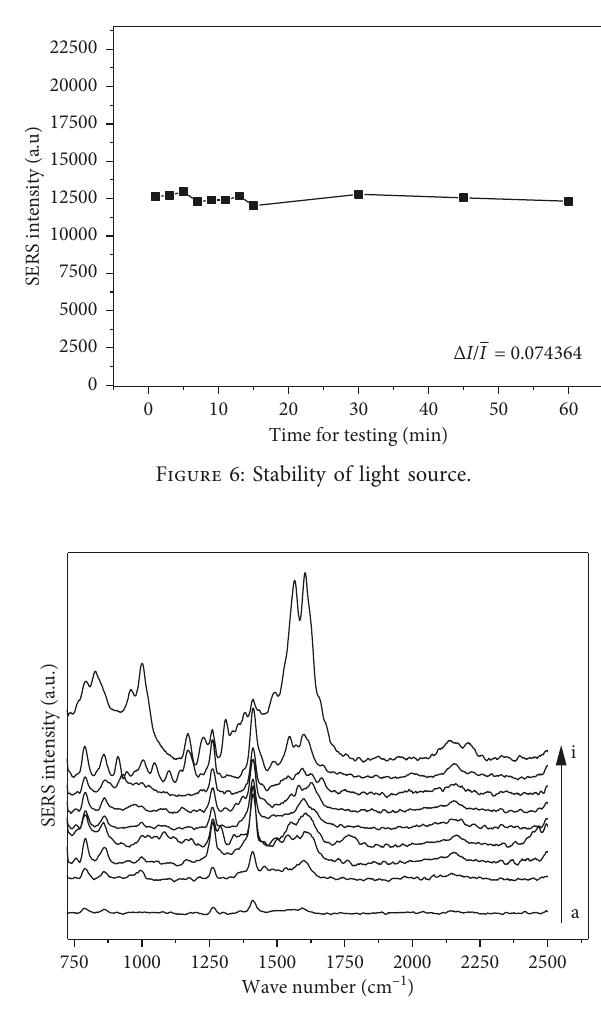
Figure 9: Curve of relationship between concentration (0.005–0.05 mg/L) of aspartame aqueous solution and character- istic peak intensity. The error bars represent the standard deviation of measurements for 12 concentrations in three separate sample runs ( n � 36).